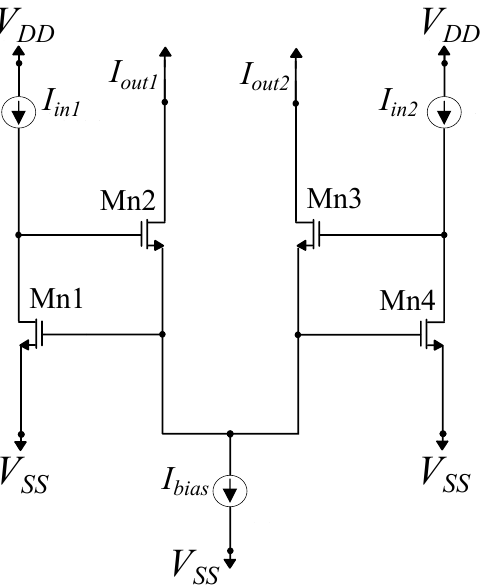
Figure 11. Simple NMOS winner-take-all circuit composed of two neuron cells. It is suitable for a 2-class classification